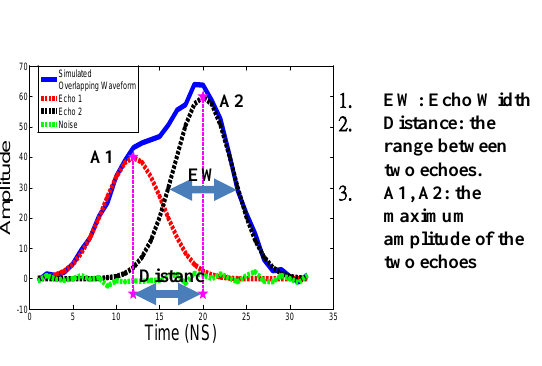
Figure 6. The factors related to the overlapped echo detection 3.4.1